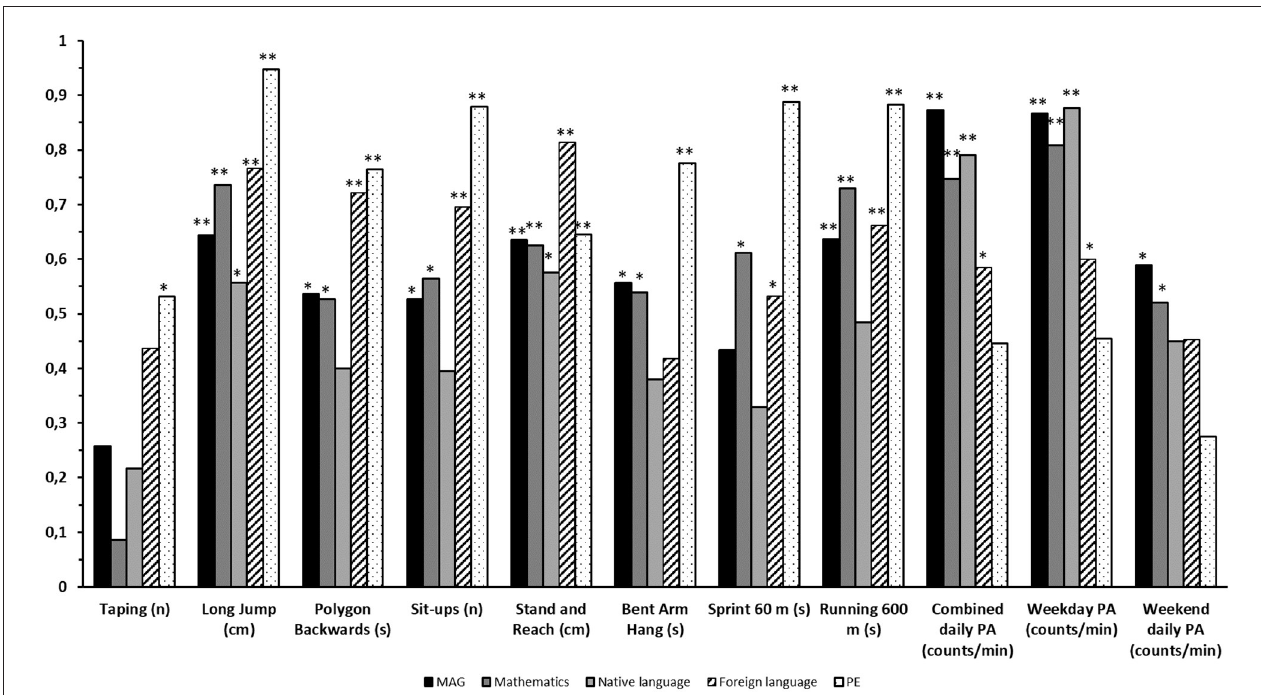
FIGURE 2 | Correlation between physical fitness and academic performance, and physical activity and academic performance. Statistically significant correlations were marked with * p < 0.05 and ** p < 0.01.